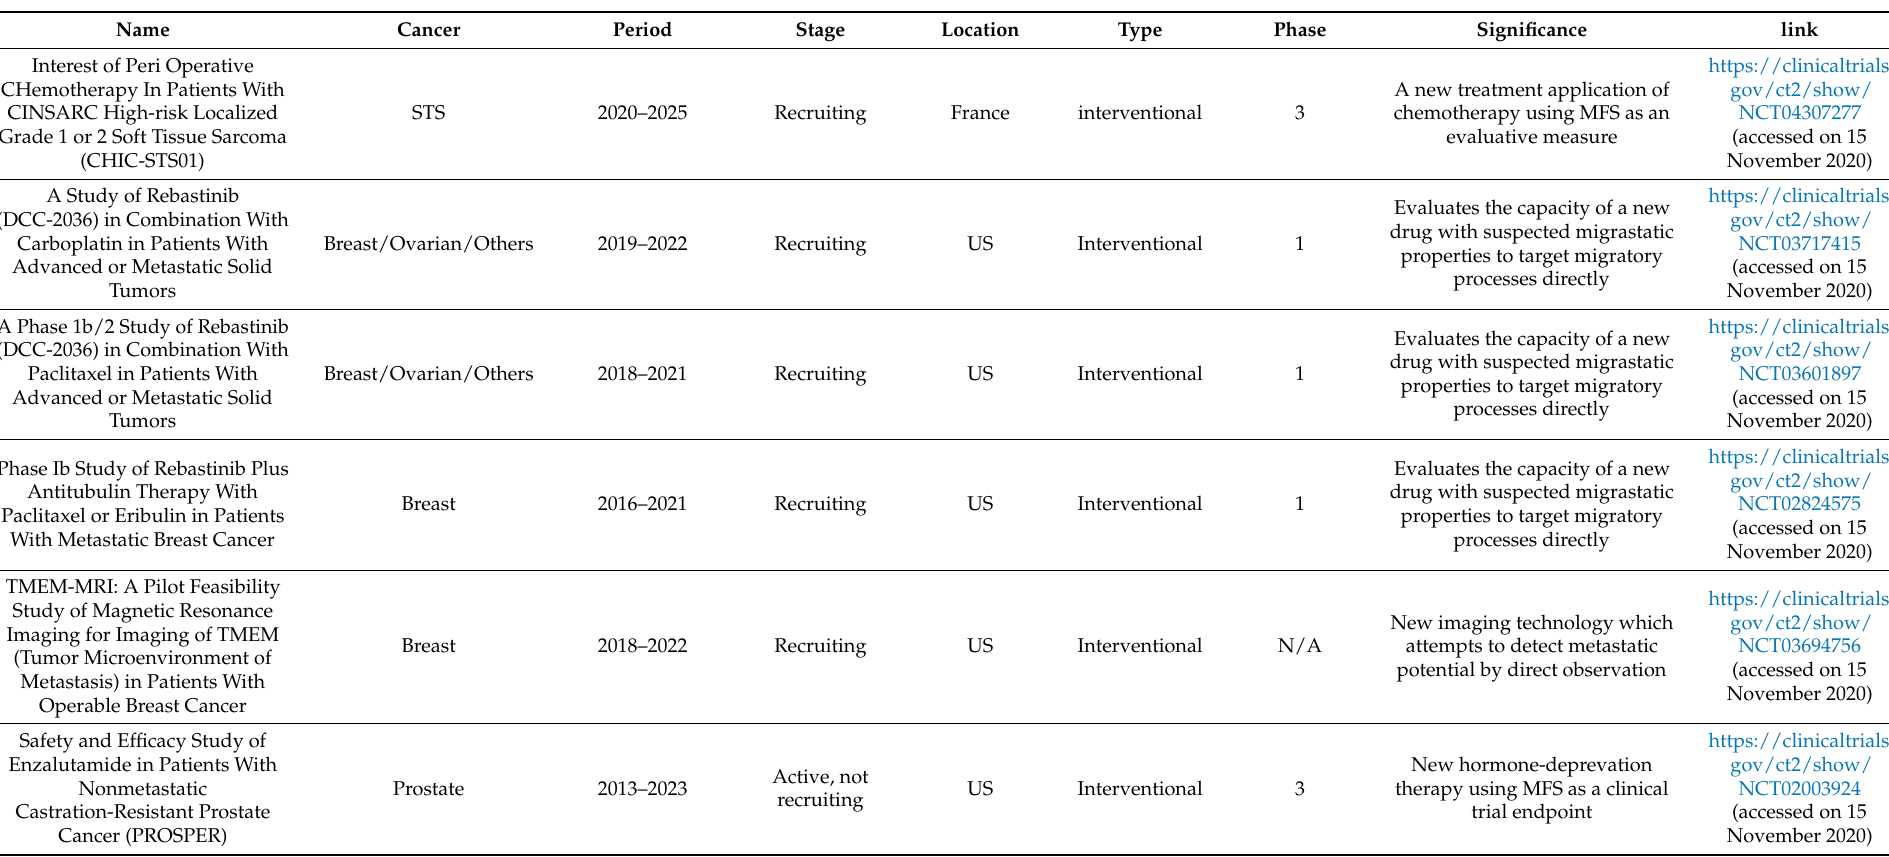
Table 1. Ongoing clinical trials in cancer metastasis as obtained by ClinicalTrials (https://clinicaltrials.gov, accessed on 15 November 2020). The search queries used to retrieve the information on clinical trials in metastasis were: All studies, “Metastasis prevention”, “Metastasis inhibition”, “Metastatic microenvironment”, “Metastasis survival”, and “Metastasis prophylaxis” as the condition/disease. The results were manually checked for